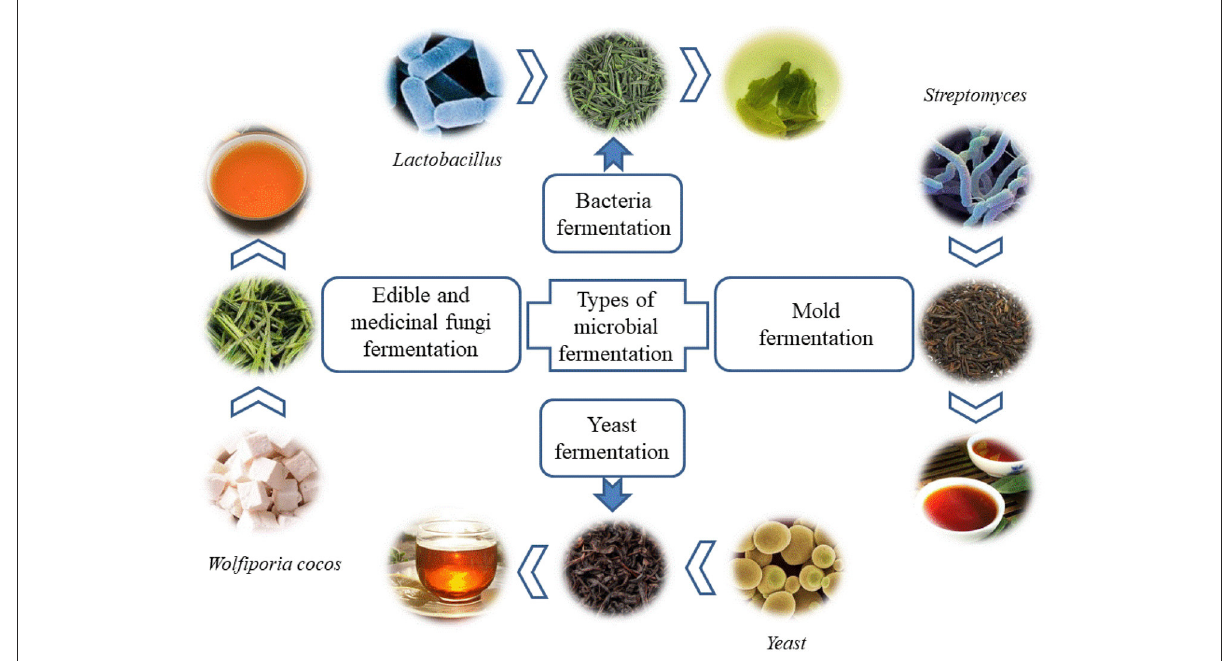
FIGURE1 Typical types of microbial fermentation in tea.